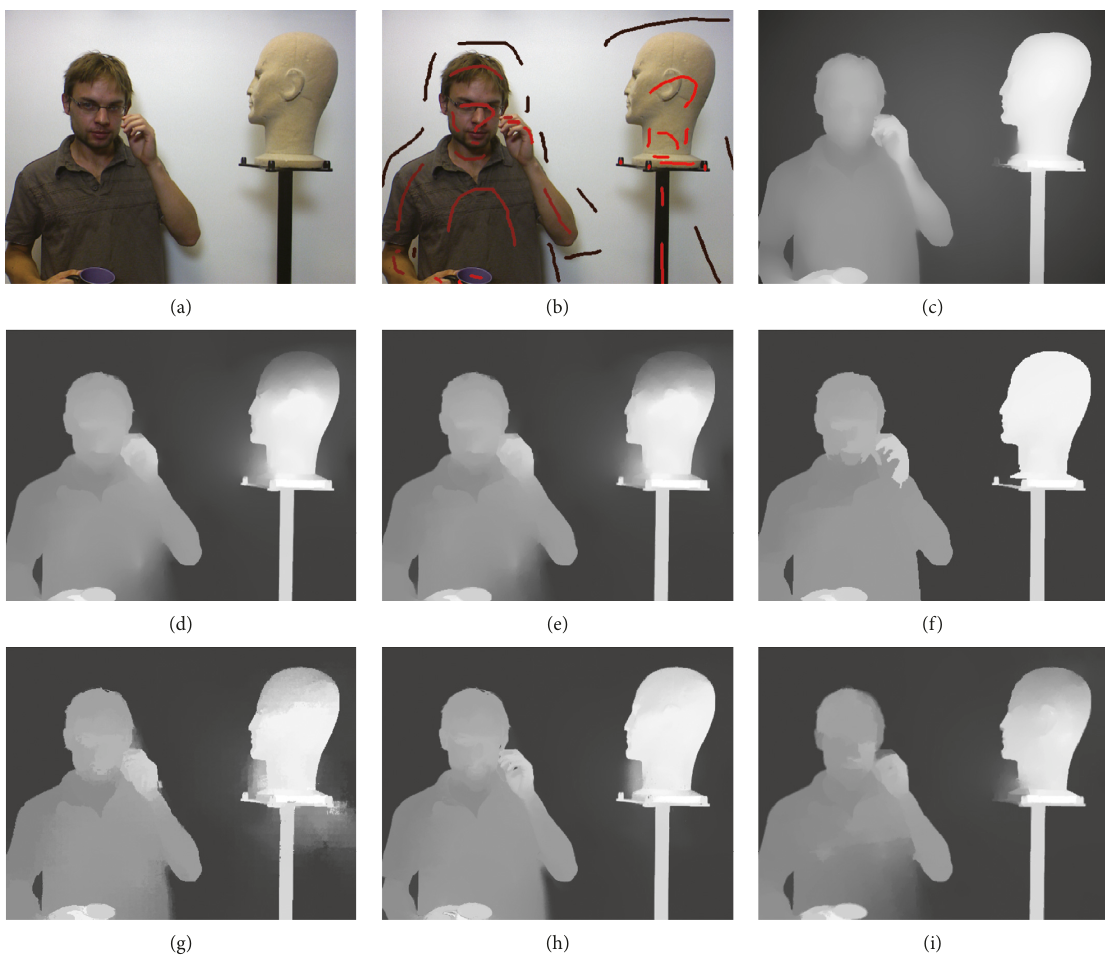
Figure 6: Results for RGBZ_05 in the absence of inaccurate scribbles. (a) Input image. (b) User scribbles. (c) Groundtruth. (d) Depth of RW [4]. (e) Depth of OPT [6]. (f) Depth of HGR [10]. (g) Depth of SOPT [13]. (h) Depth of NRW [14]. (i) Depth of